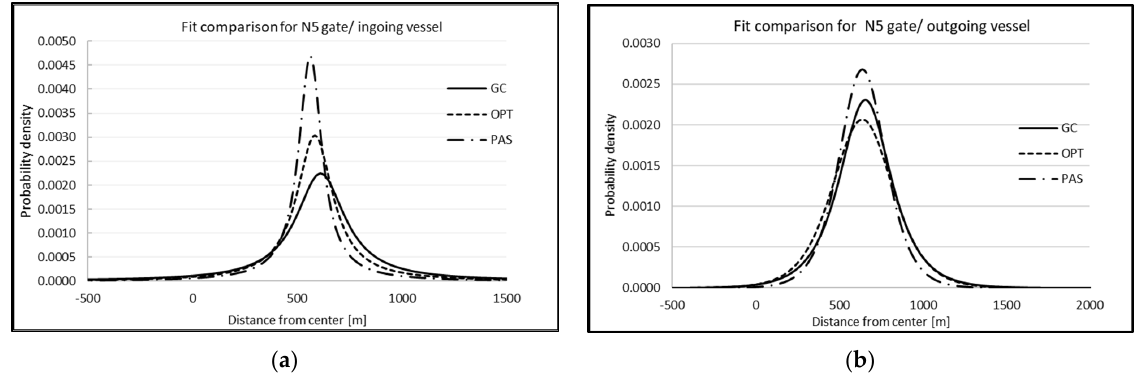
Figure 3. ( a ) Spatial distribution of ship’s position relative to track axis at leg N4, incoming traffic; ( b ) scatterplot of ships draught versus distance from centre.